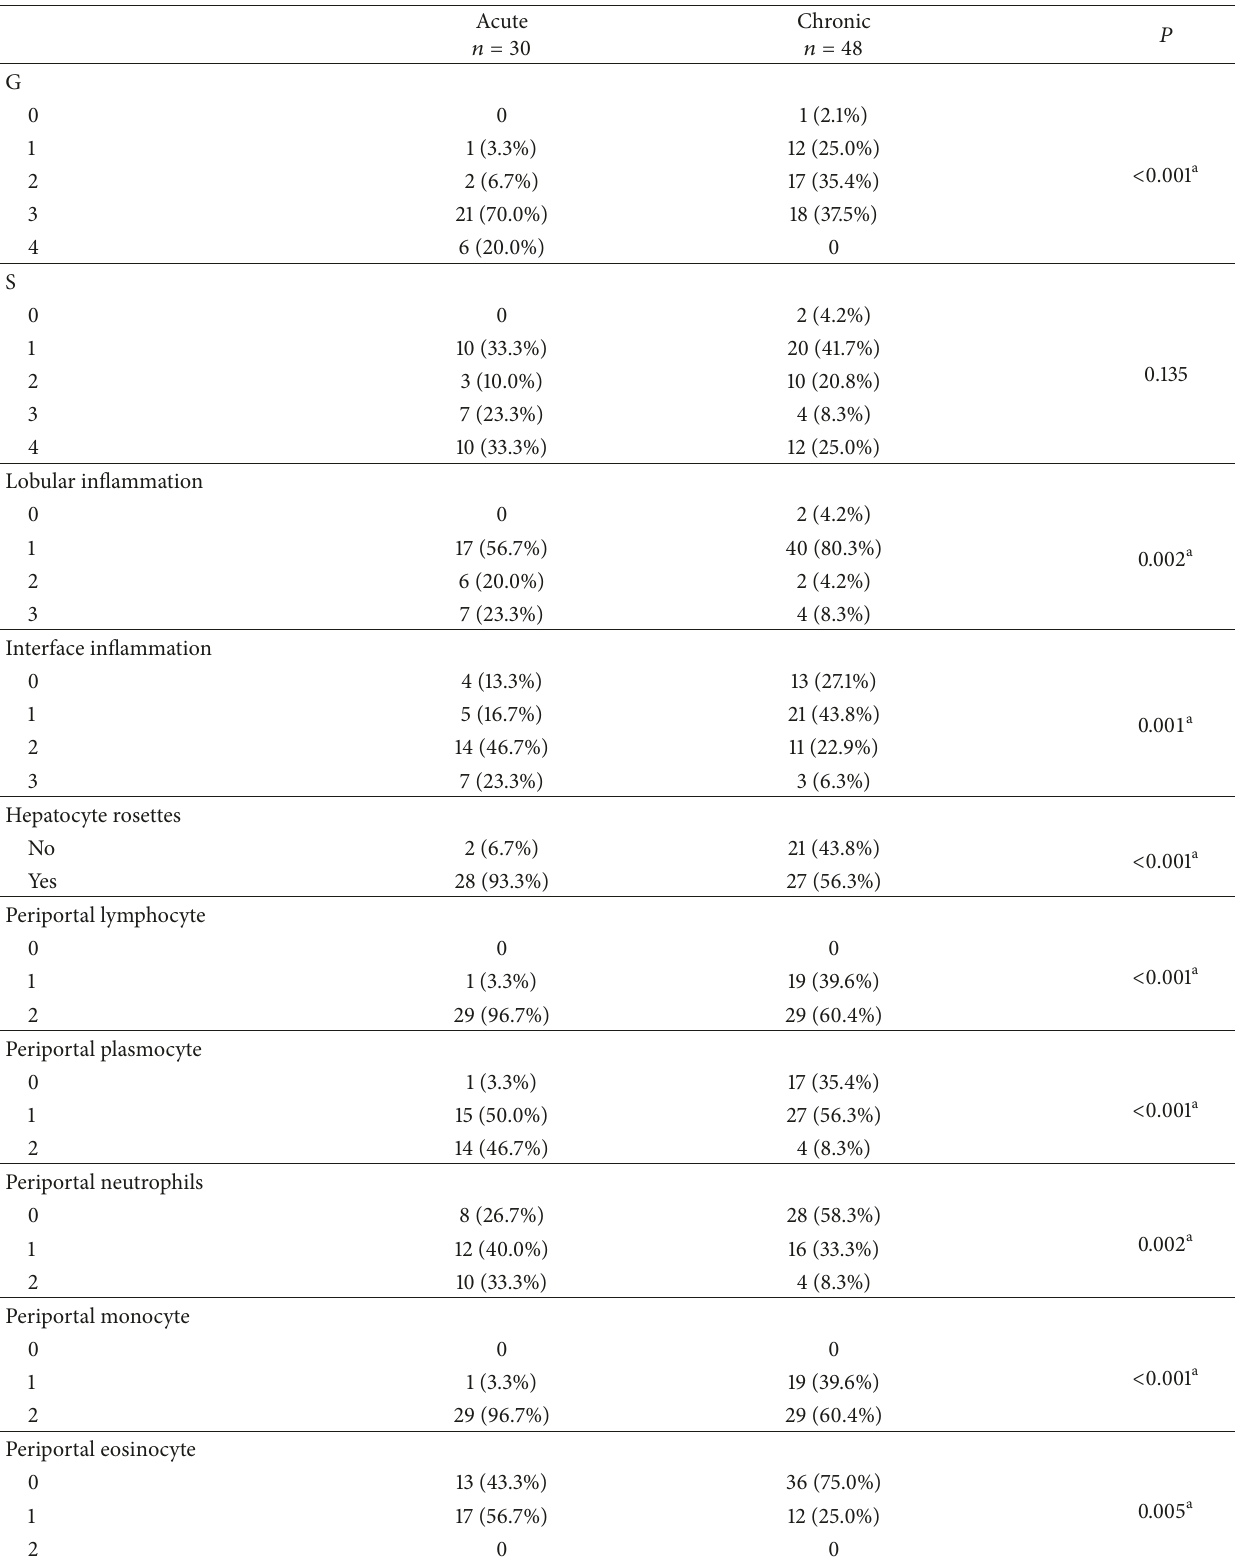
Table 3: Comparison of histological features between A-AIH and C-AIH